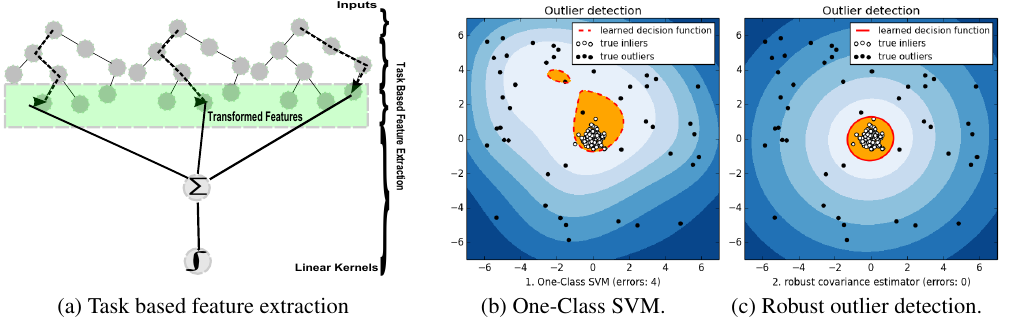
Fig. 1 Learning methods using linear and non-linear feature